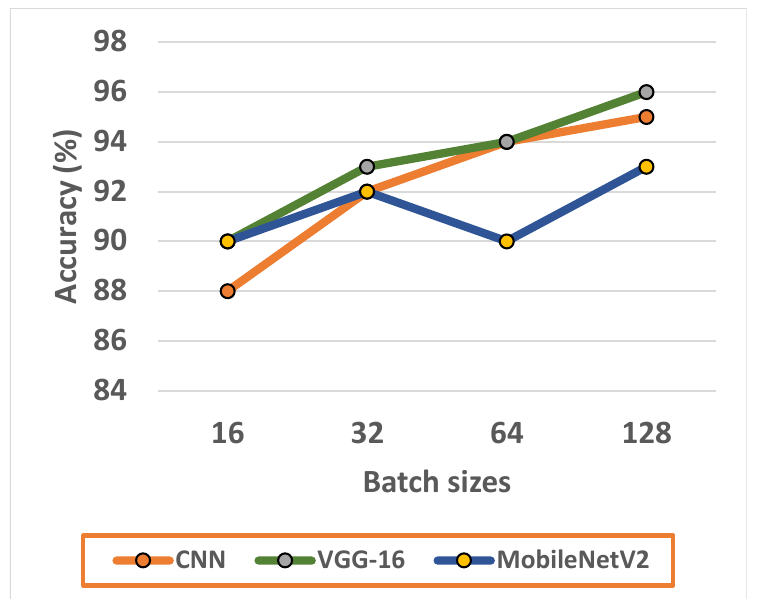
Figure 17. Testing accuracies of the deficiency nutrients with variant batch sizes.